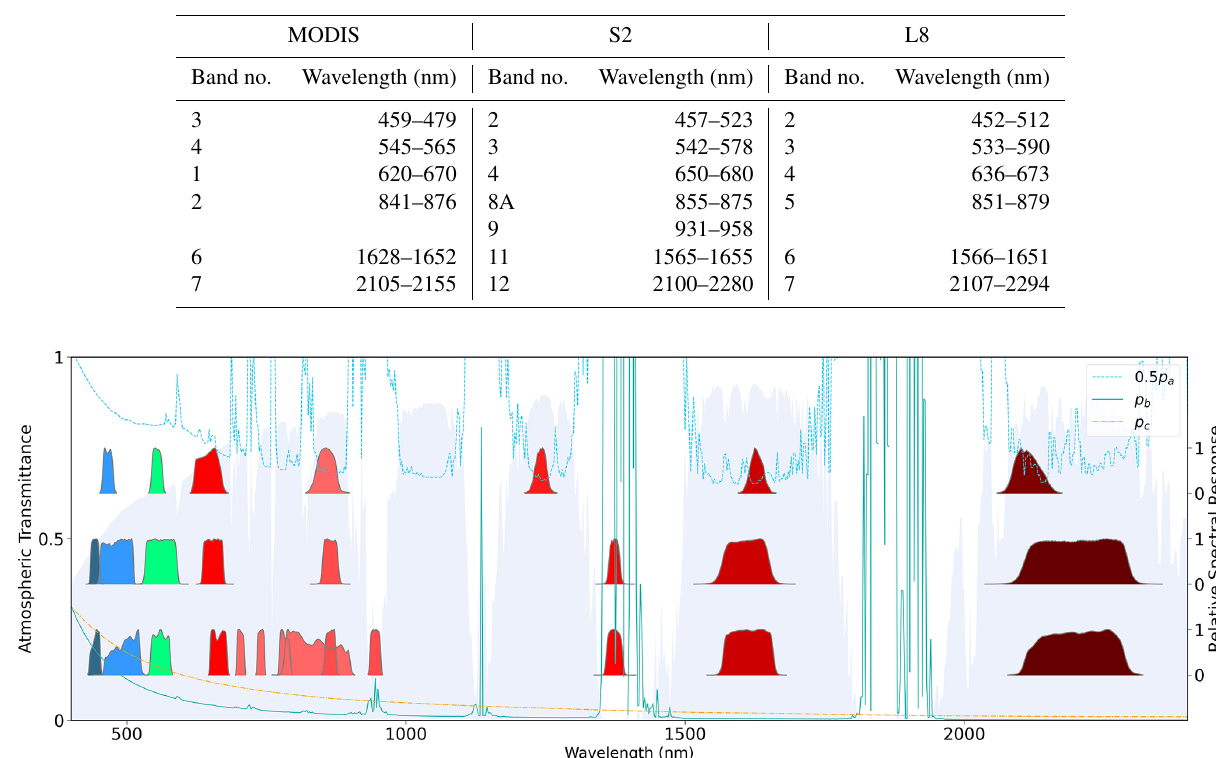
Figure 2. From the top to bottom are the MODIS, L8, and S2 relative spectral response functions for each band, and the background is the atmospheric transmittance processed by 6S with US62 atmosphere profile and continental aerosol model with an AOT value of 0.2 at 550nm.